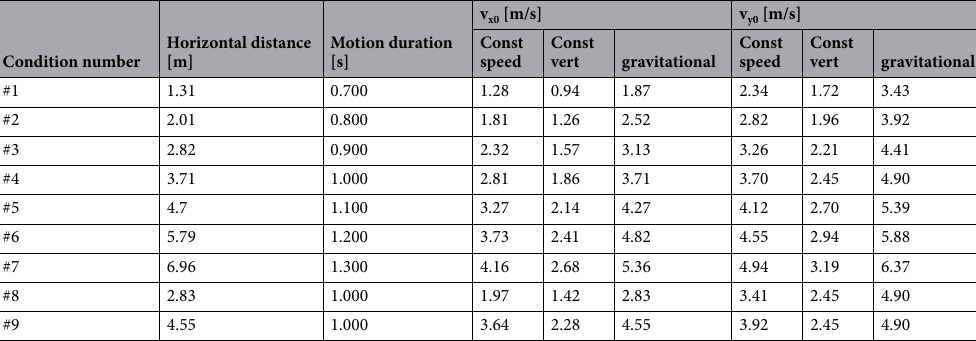
Table 1. Experimental (#1-#7) and control (#8, #9) conditions Condition #4 is the reference. v x0 and v y0 are the initial horizontal and vertical velocity,